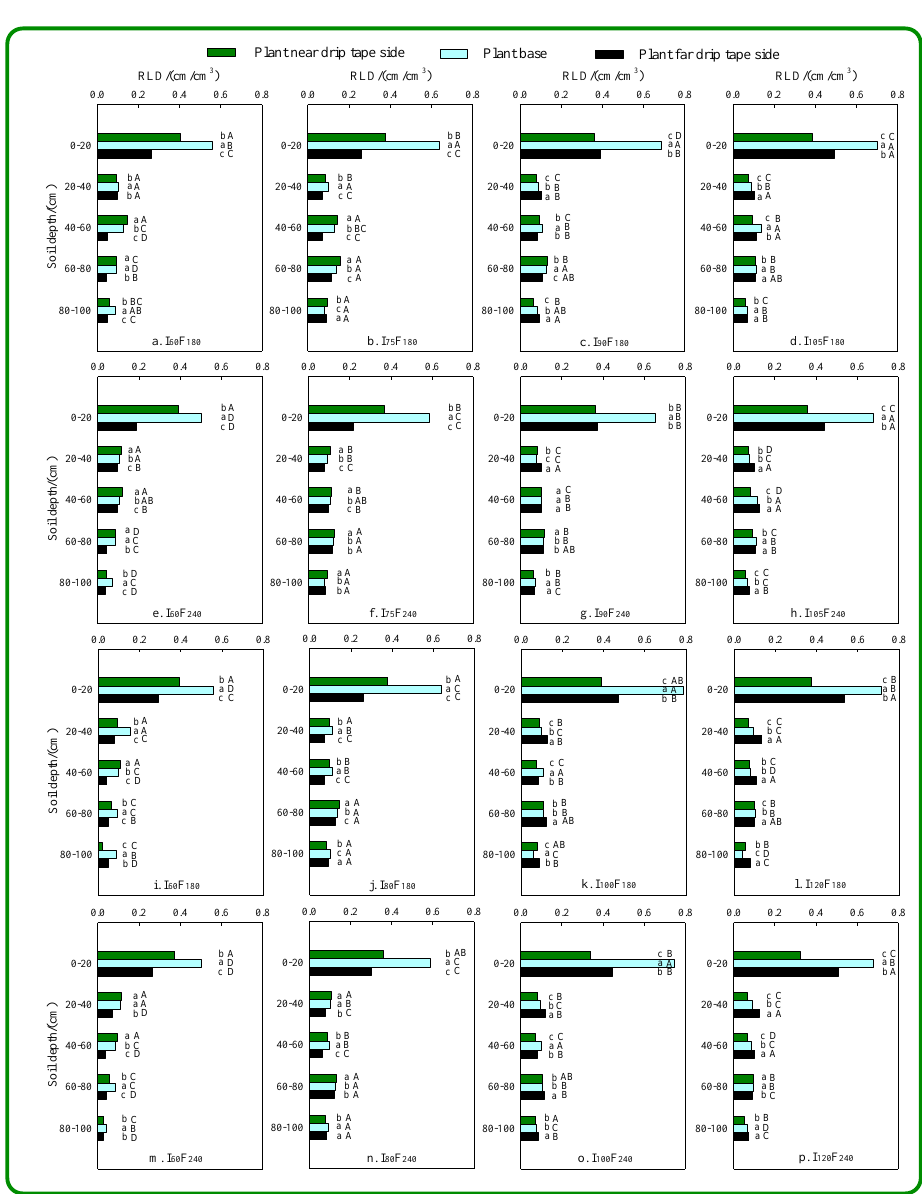
Figure 9. RLD at various soil depths of spring maize in different irrigation and fertilization treatments in 2015 and 2016. Different lower-case letters denote significant differences at p < 0.05 among different locations. Different upper-case letters denote significant differences at p < 0.01 among different locations.